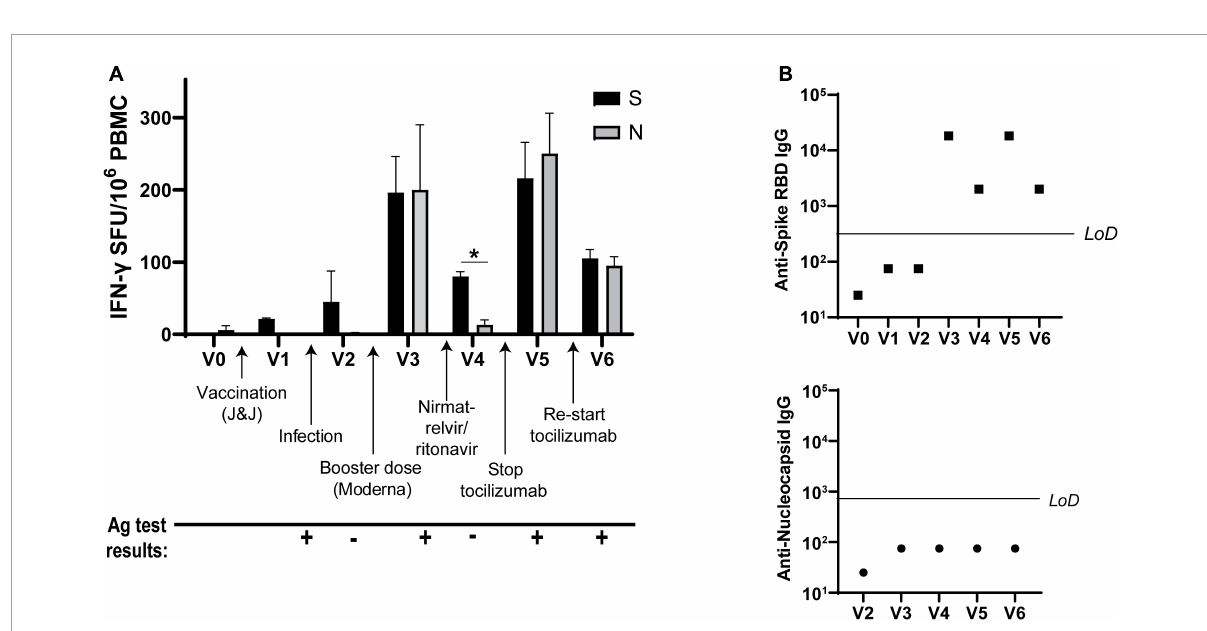
FIGURE2 IFN- γ T cell responses to SARS-CoV-2 vary over time. (A) IFN- γ production from SARS-CoV-2 Spike- and Nucleocapsid-specific T cells at each visit as determined by ELISPOT. (B) Spike receptor-binding domain (RBD)-specific IgG titers (top) and Nucleocapsid-specific IgG (bottom) at each visit. LoD, limit of detection. All ELISPOT data in panel (A) from duplicate wells. Data representative of 2 individual experiments, * p < 0.05 by Student’s t